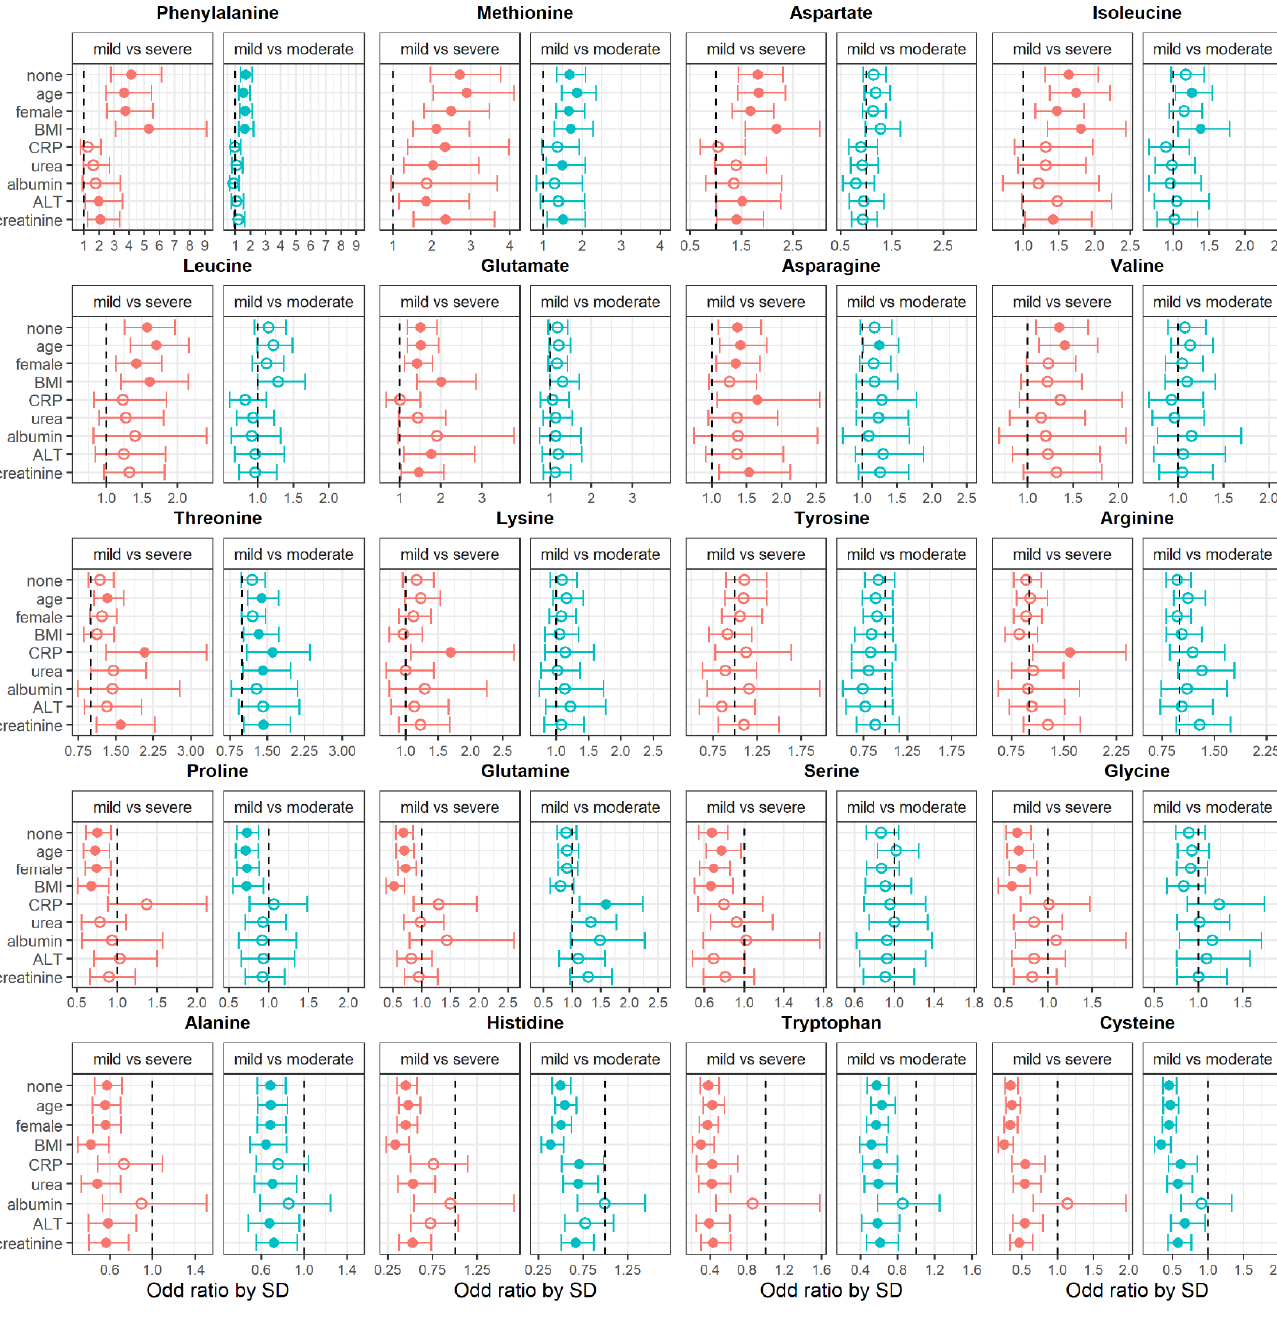
Figure 2. Odds of having mild vs. severe, or mild vs. moderate COVID ‐ 19 symptoms associated with circulating ‐ amino ‐ acid levels unadjusted (none) and adjusted for clinical variables. Results are presented as odds ratios per 1 standard ‐ deviation (SD) increase in amino ‐ acid level. The number of observations for each models varies; see Table 1 for the number of observations available for each variable. The x ‐ axis scale is different for each amino acid. Full circles indicate a significant association and empty circles indicate a non ‐ significant association. BMI: body mass index, CRP: C ‐ reactive protein, ALT: alanine aminotransferase. For CRP, patients receiving tomizumab were excluded because it negates the measurement.